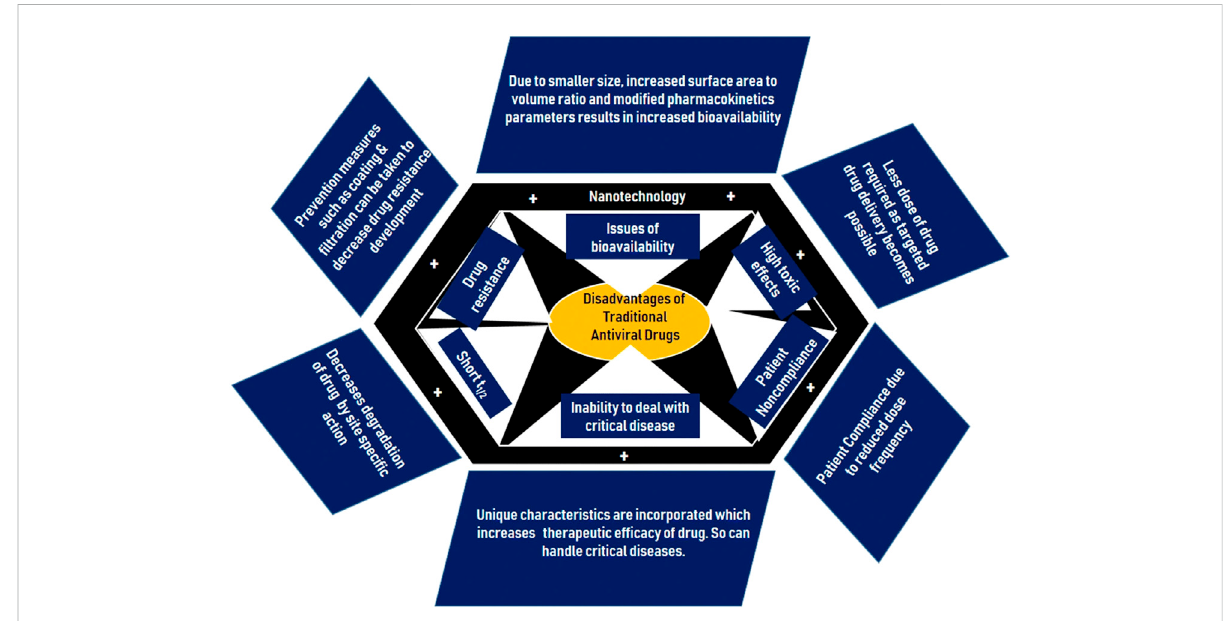
FIGURE 4 Summaryoftheshortfallsoftraditionalantiviralsandmethodsofrevisionwithnanoparticles(ChakravartyandVora,2021).Permissiontousethis fi gure is available. This fi gure is reprinted with permission from Springer Nature from (Chakravarty and Vora, 2021).